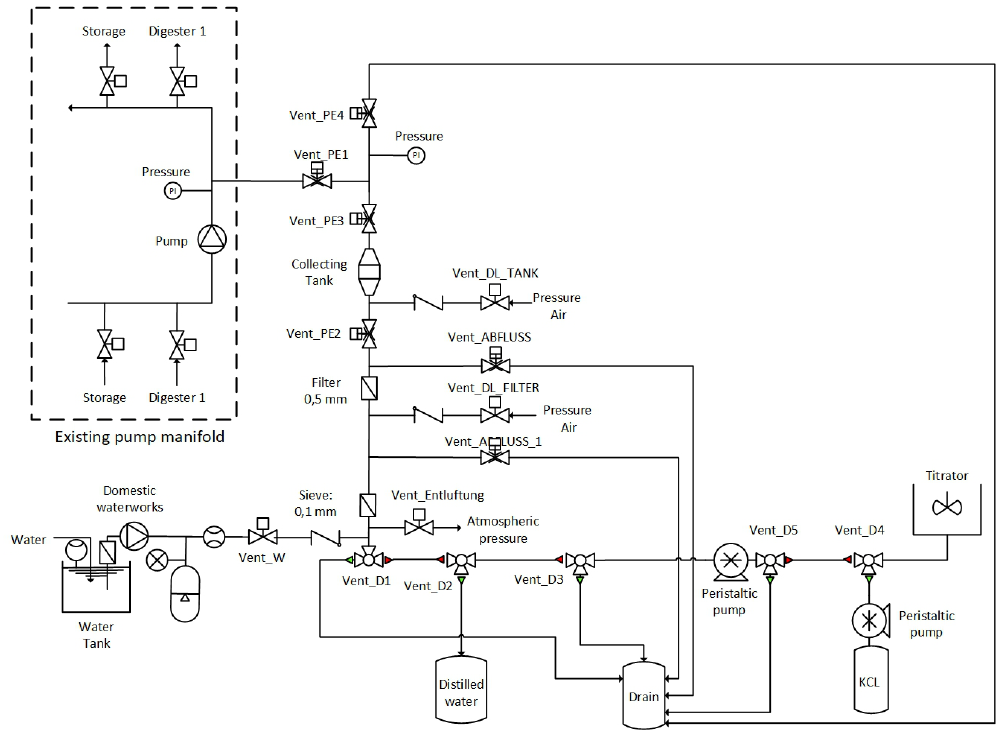
Figure 1. Process diagram sampling